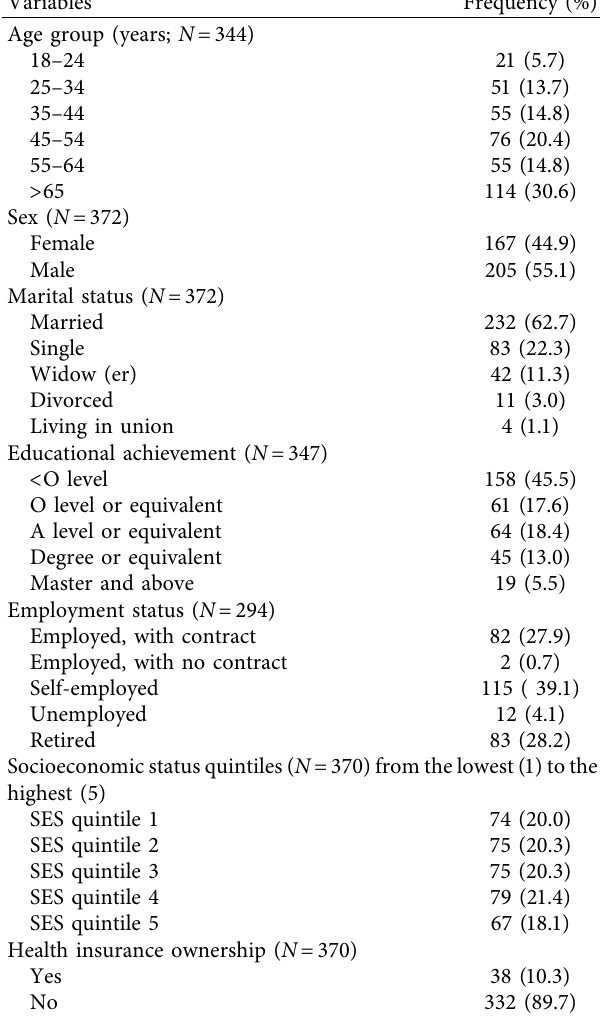
Table 1: Demographic and socioprofessional characteristics of study participants.